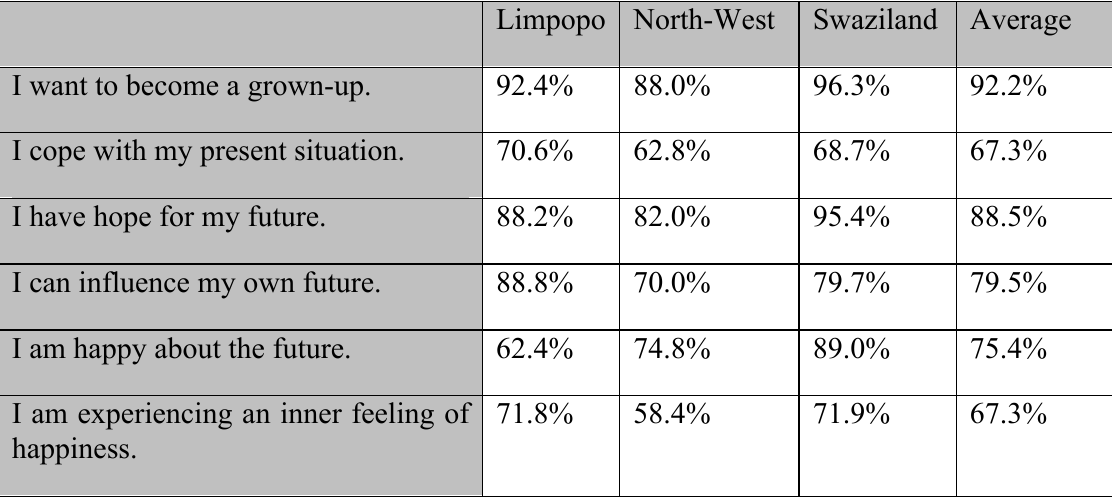
Table 7. Orphans’ responses regarding their own future and feeling of happiness